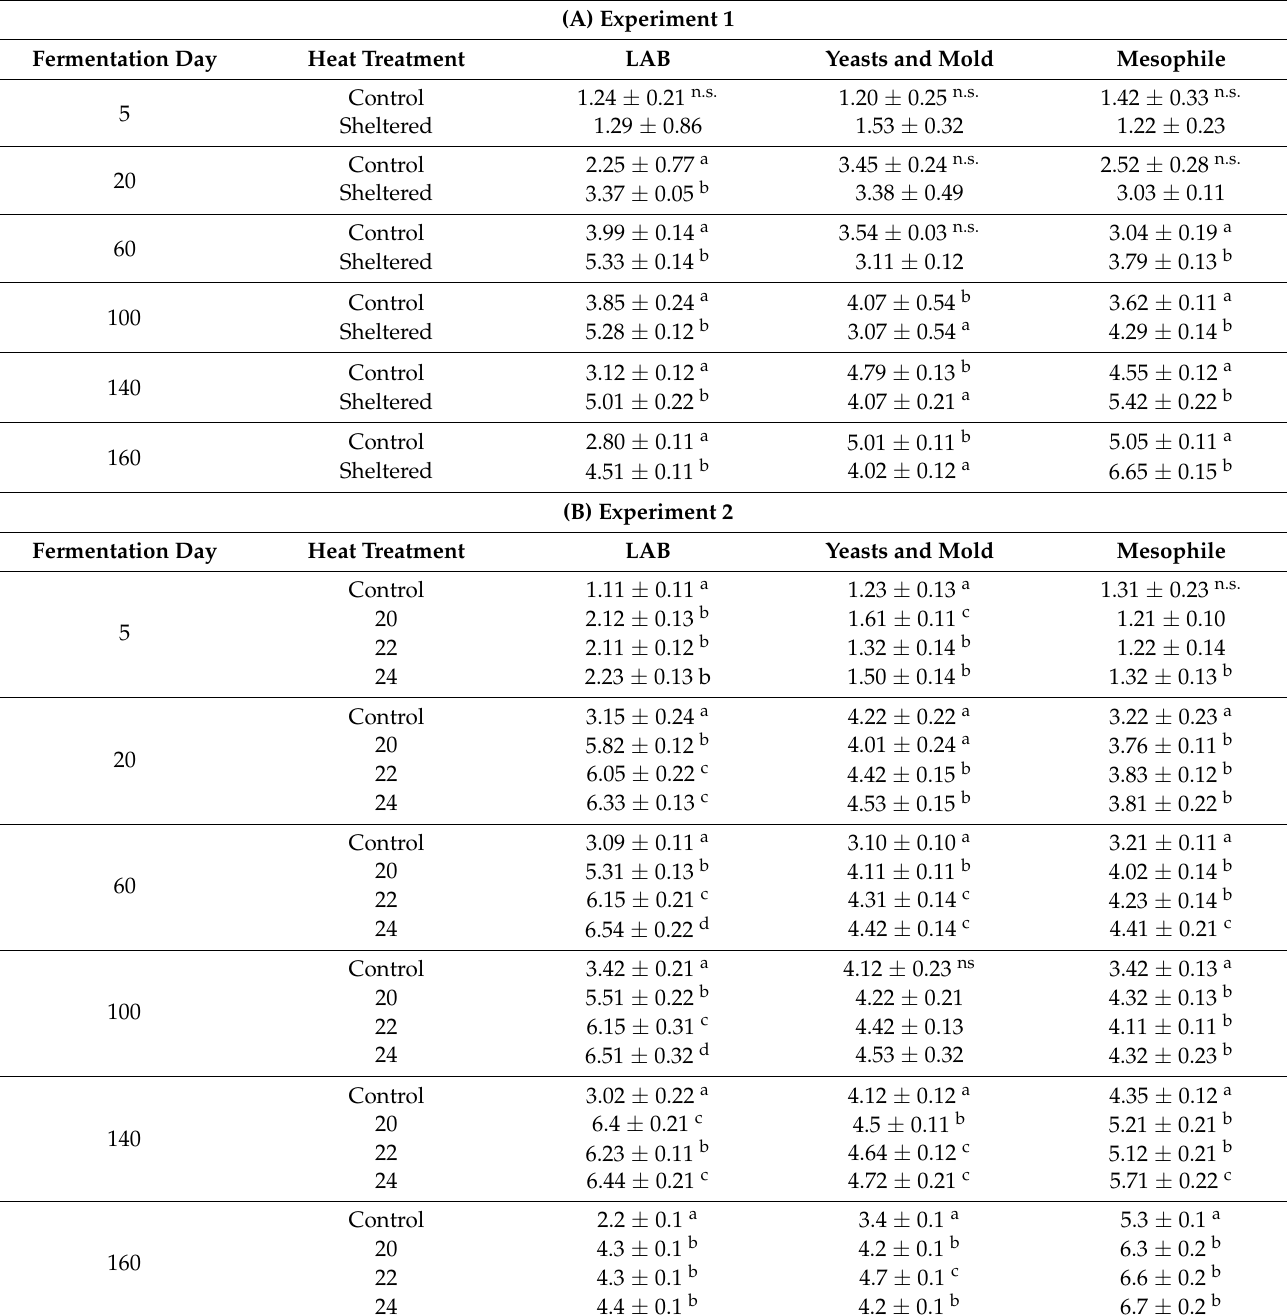
Table 1. Viable counts pertaining to total mesophiles, yeasts and mold, and lactic acid bacteria (LAB). Outcomes reported as mean ± SD (log 10 cfu · g − 1 ). Different superscript letters within the same column indicate statistically significant differences (Duncan’s test, p < 0.05) between thermal treatments. n.s.: non-significant